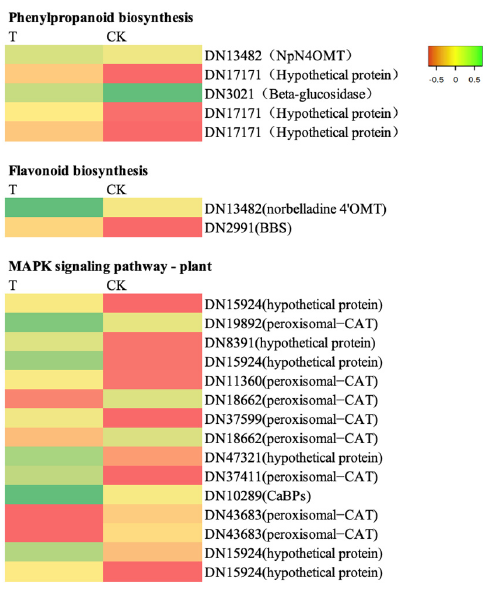
Figure 9. Heatmap of differential gene expression in the T9 treatment.